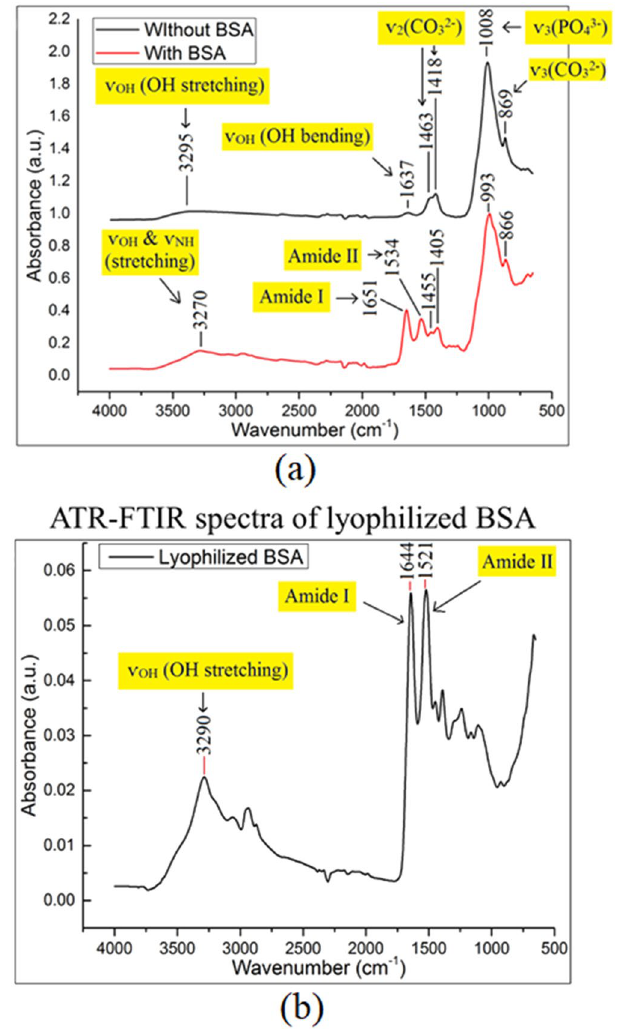
Figure 6. ( a ) Representative ATR-FTIR spectra of long-needle (LN) HA/CHA samples with (red) and without (black) 2-h BSA incubation. ( b ) Representative ATF-FTIR spectrum of lyophilized BSA acquired in